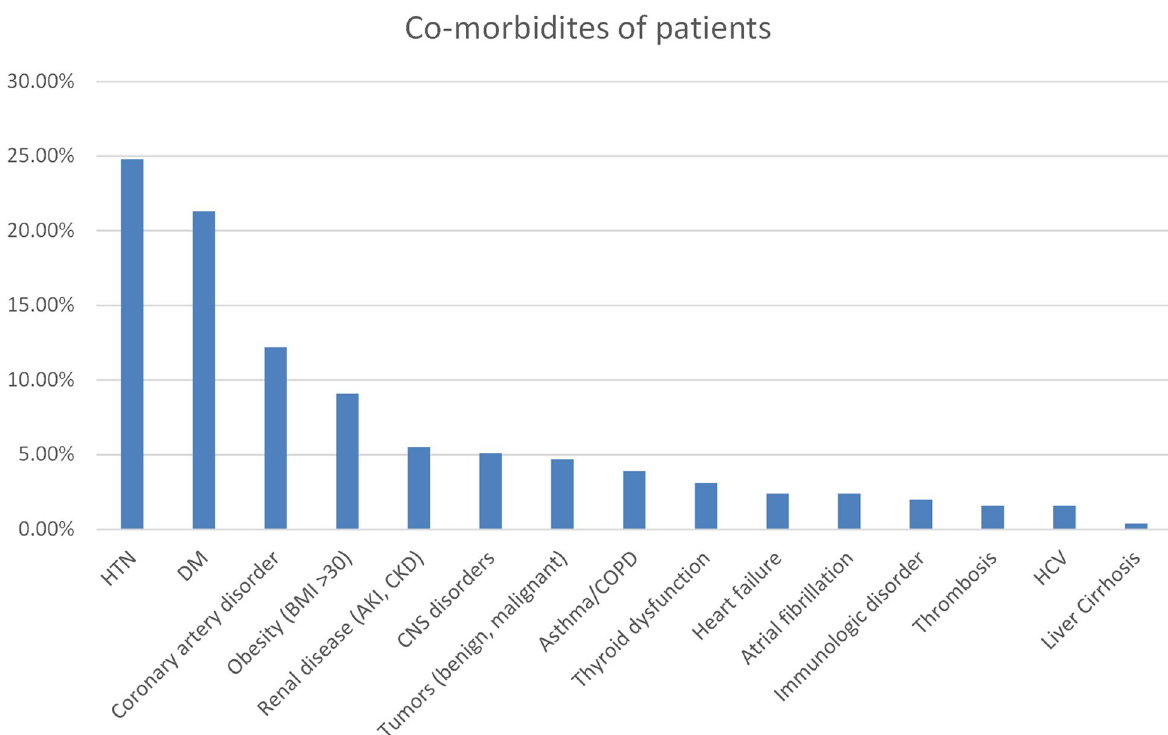
Fig. 2 Comorbidities of the 121 participants involved in the study